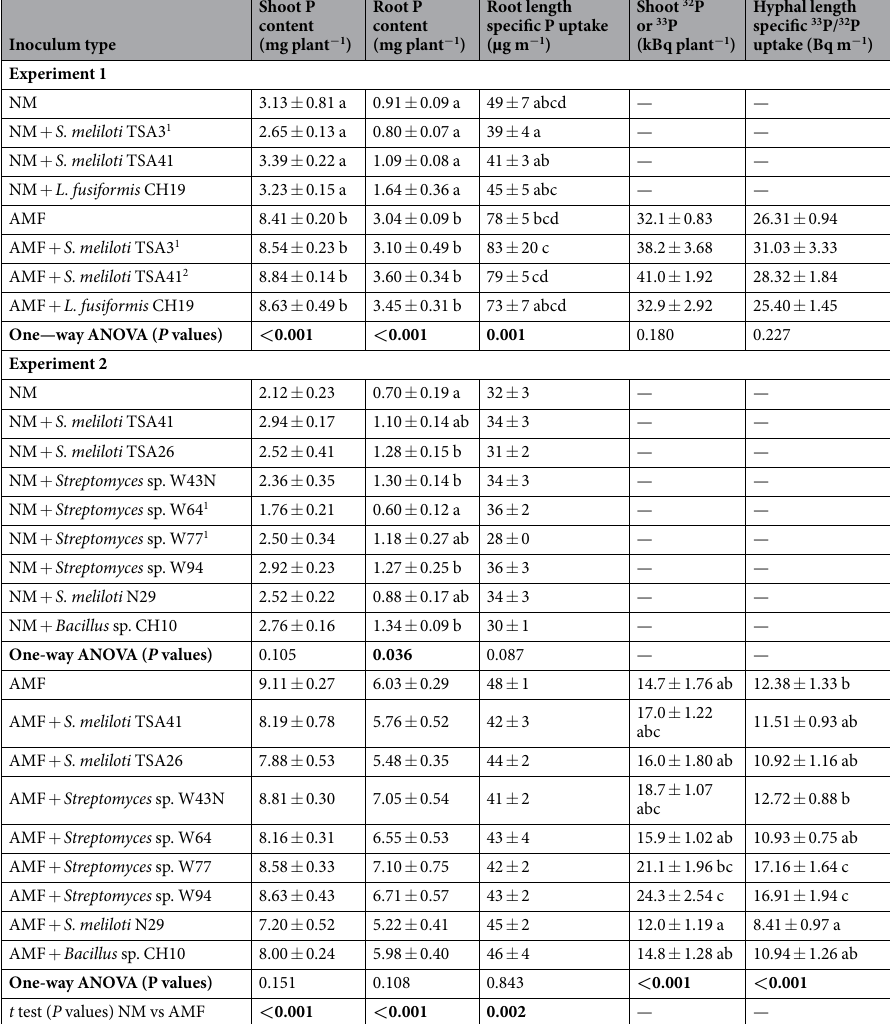
— — Table 2. P content and P uptake of Zea mays L. genotype Oh43 inoculated, or not (NM), with Rhizophagus irregularis (AMF) alone or in combination with different bacterial strains. Data are presented as the mean ± s.e.m. (n = 5). Different letters indicate significantly different values ( P < 0.05). As AMF inoculation strongly increased plant variables, not allowing the satisfaction of data normality and homogeneity of variances, values of mycorrhizal and NM plants were analysed separately by one-way ANOVA, followed by Student’s t test to compare the pooled means. * Values in bold type indicate factors that had significant effects. 1 Treatment with four biological replicates; 2 Treatment with three biological